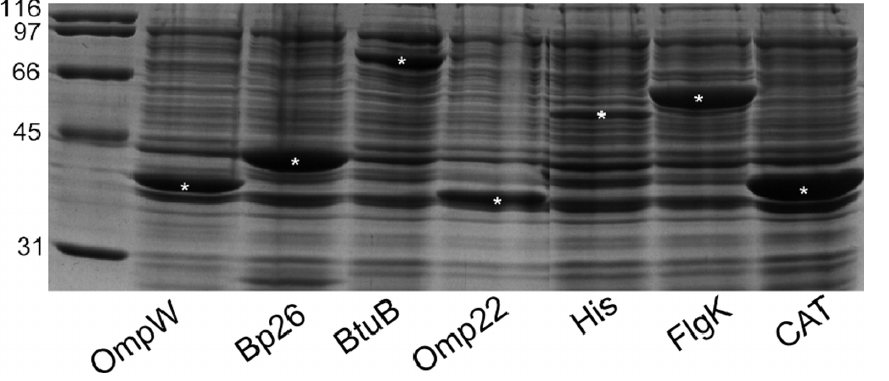
Figure 1. Whole cell lysate from BL-21 E.coli transformed with pET-SUMO-BME constructs. Bacteria were grown to log phase in LB broth supplemented with antibiotic and then stimulated with IPTG for 2.5 hours. Bacterial lysates were diluted with SDS loading buffer, incubated at 95 u C for 5 minutes and electrophoresed in a 12.5% SDS-PAGE gel.